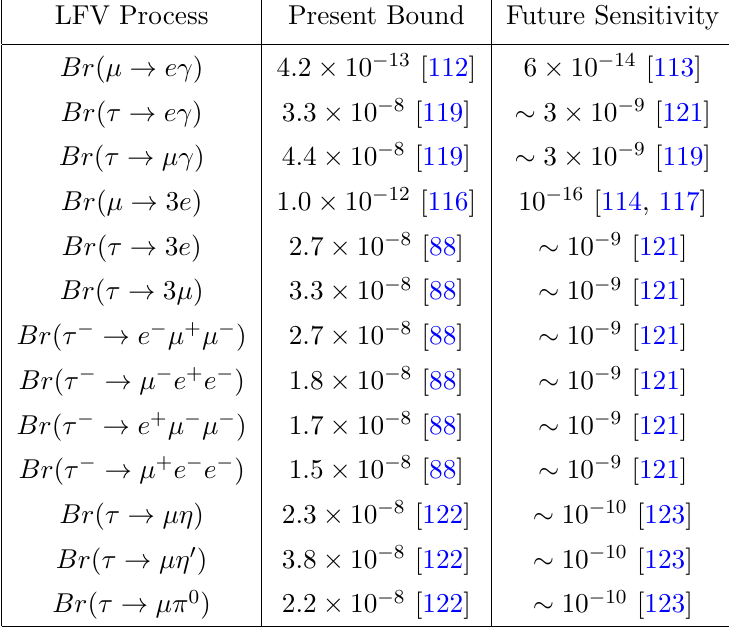
Table 1. Current Experimental situation and future sensitivities for principal LFV